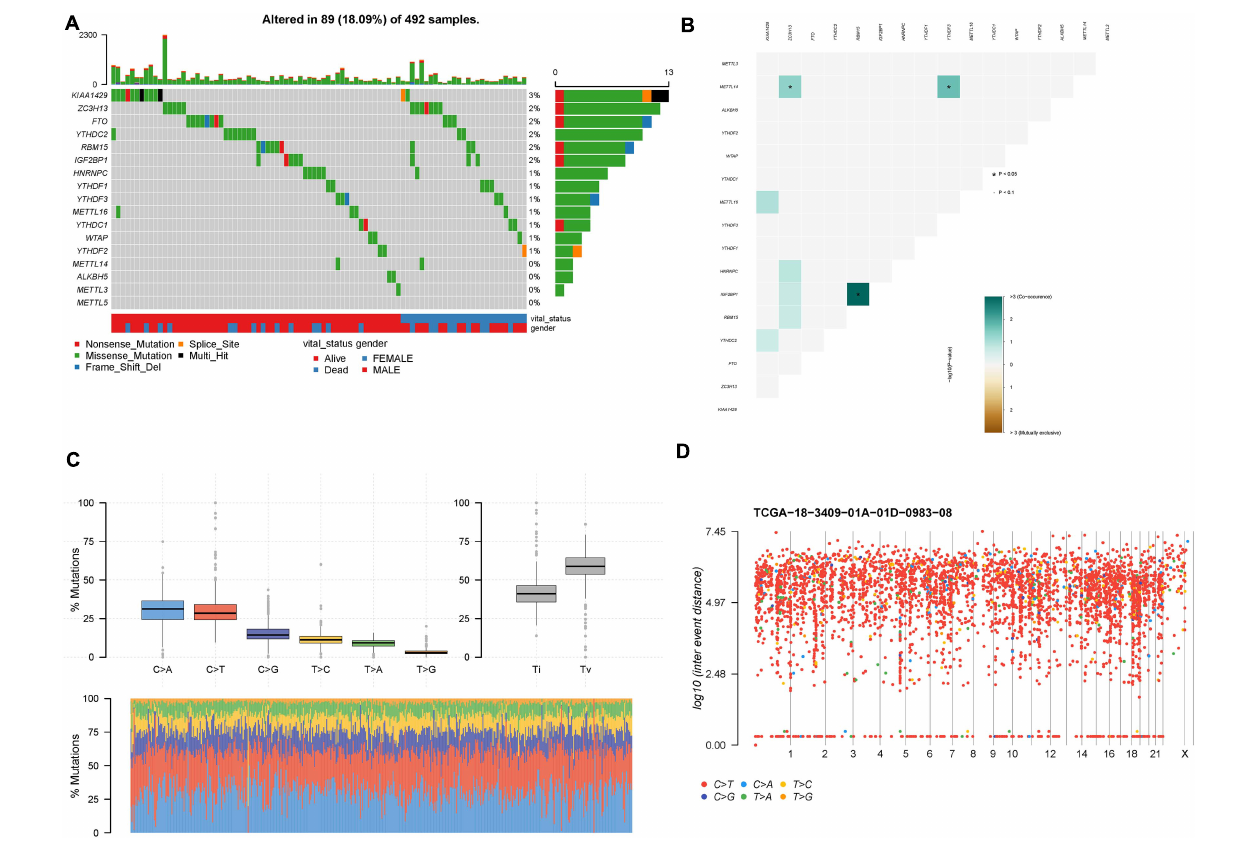
FIGURE 2 | Mutation patterns of LUSC patients. (A) Oncoplot displays the mutational patterns of m6A-related genes in 89 LUSC patients. (B) The co-expression patterns of m6A-related genes in LUSC patients. (C) The SNP patterns of LUSC patients. (D) Rainfall plot shows hypermutated genomic regions. * p < 0.05.